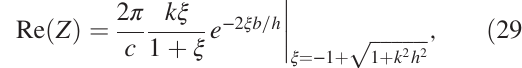
FIG. 7. The real part of the Joule heating impedance Re ð Z Þ þ Re ð Z Þ for the beam passing by a single dechirper Re ð Z hz hx plate, for the case of plate width w → ∞ (blue curve), with the constituent parts given in dashes. The beam passes by at offset b ¼ 0 . 25 mm from the plate. The area under Re ð Z is 42% [58%] that under Re ð Z Þ .